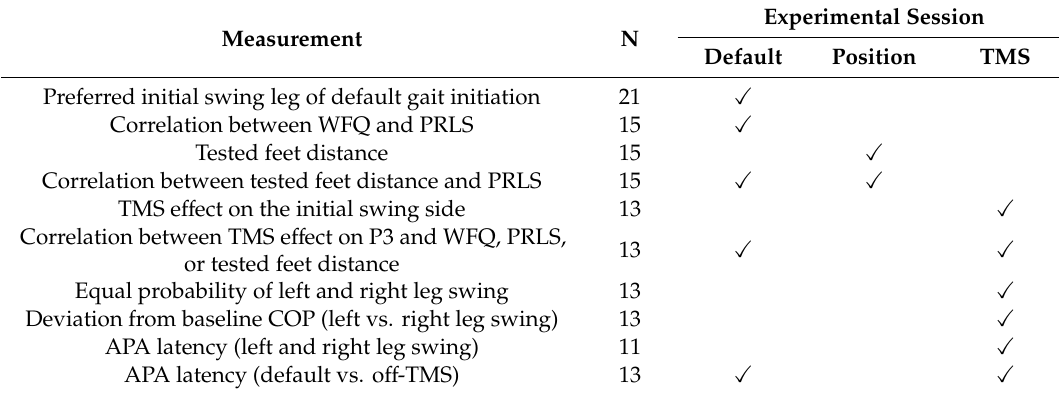
Table 1. Measurements, number of participants included, and experimental session.